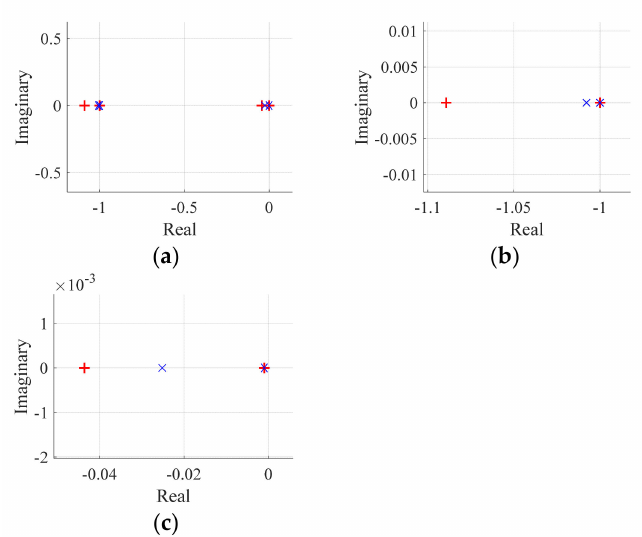
Figure 8. ( a ) Dominant Eigenvalues of the TL VSI and the DTL VSI; ( b , c ) zoomed photos of ( a